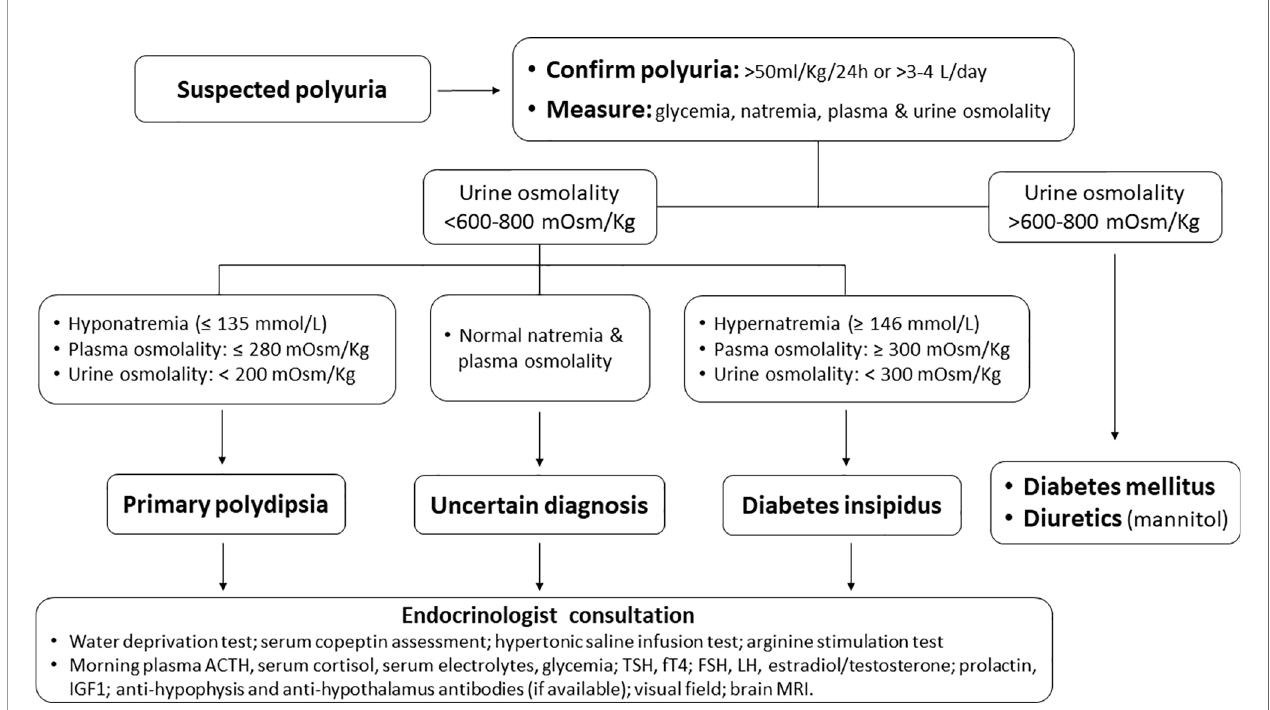
FIGURE 1 | A diagnostic fl ow-chart for patients presenting with suspected